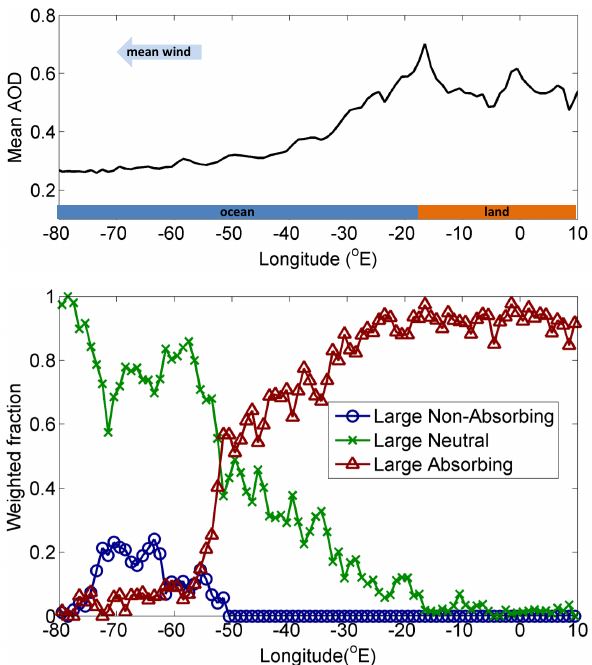
Figure 5. Transect showing transport of mineral dust plumes. Shown are summertime (June–August 2007–2011) data from 15– 20 ◦ N, a region of Saharan dust outflow. Upper panel: mean AOD (total of all aerosol types); the mean wind direction is indicated by an arrow, and the surface type (land or ocean) is given at the bottom of the panel. Lower panel: AOD-weighted fraction of all aerosol types contributing > 20% to